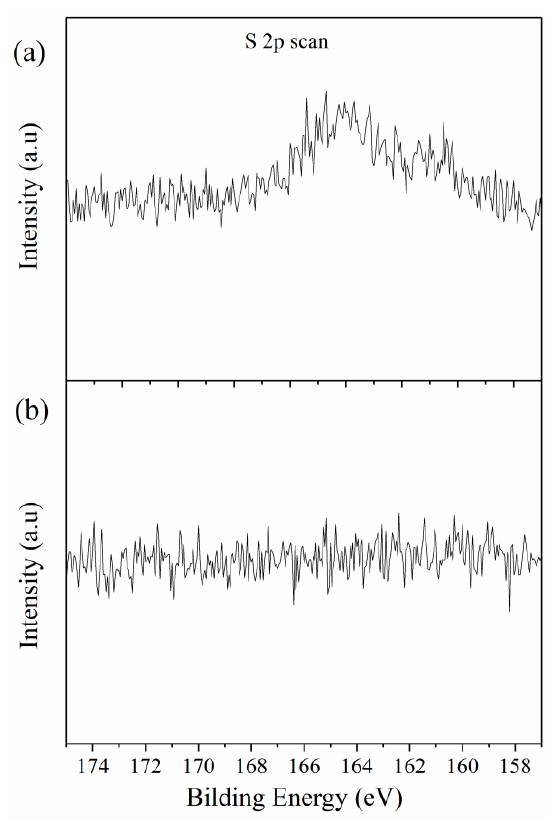
Figure 8. XPS spectra of S 2p electron in ( a ) a sample of Pt – SnO 2 nanoceramic exposed to H 2 S at room temperature and ( b ) a sample of Pt – SnO 2 nanoceramic heat-treated at 160 °C for 10 min in air after H 2 S exposure.